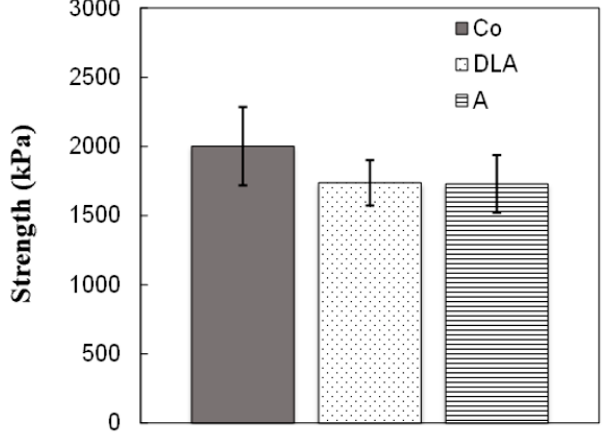
Figure 12. Indirect tensile strength values for unconditioned mix (Co) and conditioned mixtures (DLA and A).